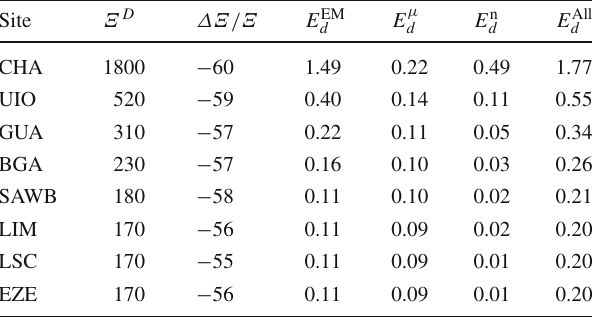
Table 2 Expected signal flux, Ξ D , in a single LAGO like WCD deployed at the ground level of the eight selected sites used as exam- ples of the ARTI capabilities in this work. The percent relative dif- ference of the expected signals to the expected flux of particles, i.e., ΔΞ/Ξ = (Ξ D − Ξ)/Ξ %, and the deposited energy for the differ- ent EAS components of the are also shown: electromagnetic compo- μ nent E EM , muon component E , neutrons E n , and the total deposited d d d energy E All . For the hadronic component, we only show the neutron d contribution. The remaining hadronic contribution can be obtained by